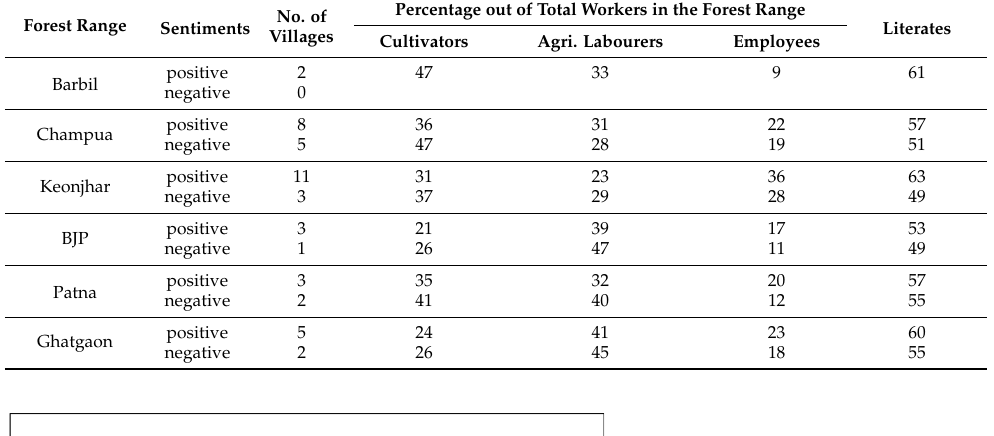
Table 2. People’s sentiments classified by demographic categories within the forest ranges impacted by human-elephant conflict of the Keonjhar district.